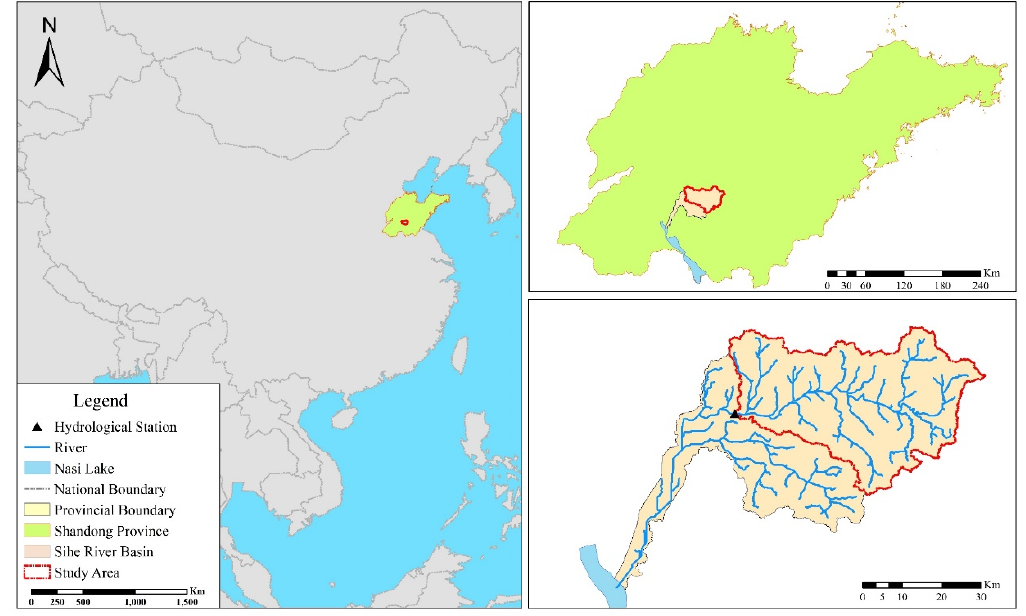
Figure 2. Location of the study area.